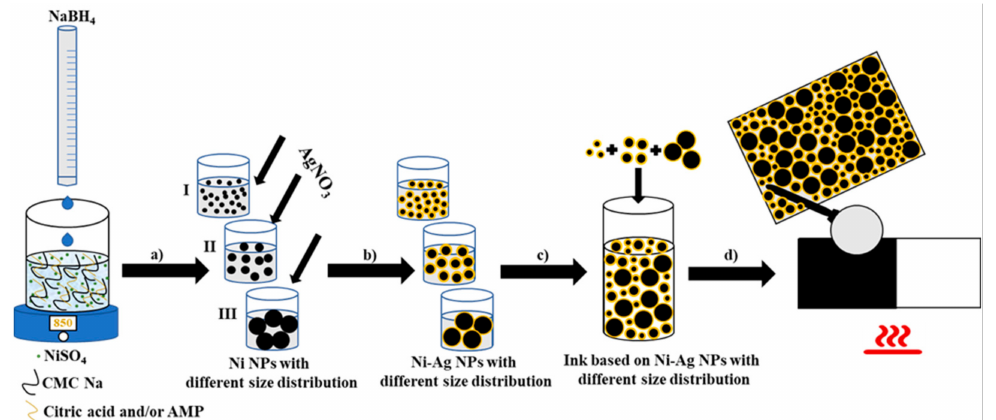
Figure 1. Scheme of the preparation of conductive coatings based on Ni-Ag NPs: ( a ) optimization of the process of synthesis of Ni NPs with different size distributions; ( b ) formation of Ni-Ag NPs by transmetalation method; ( c ) preparation of ink containing Ni-Ag NPs with various sizes; ( d ) fabrication of conductive metallic